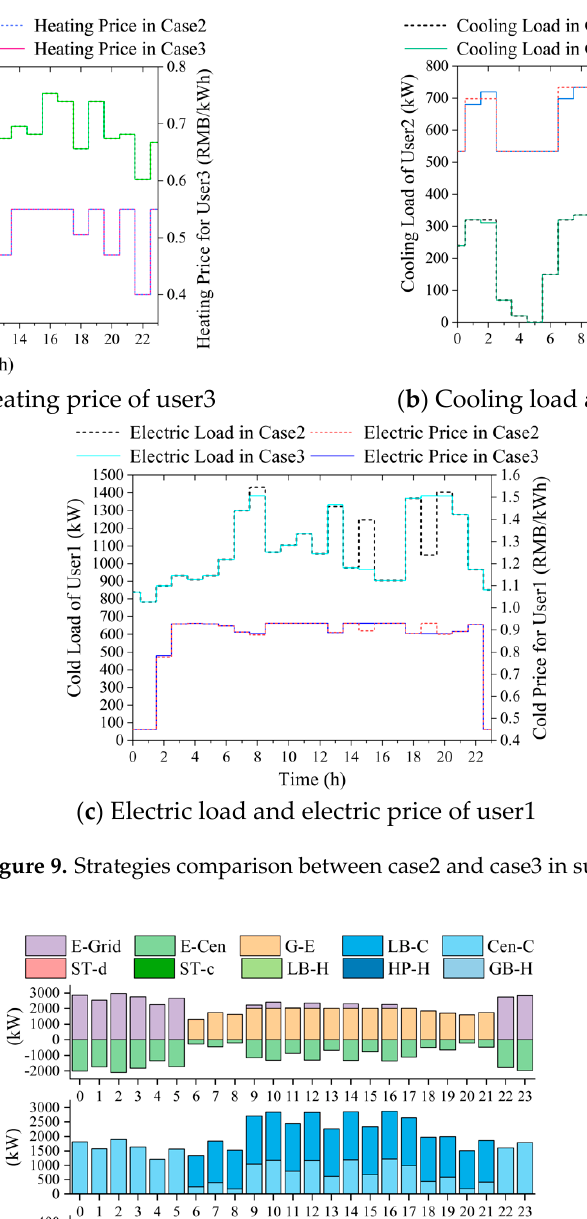
Figure 10. The output of operator’ equipment in case2 in summer.